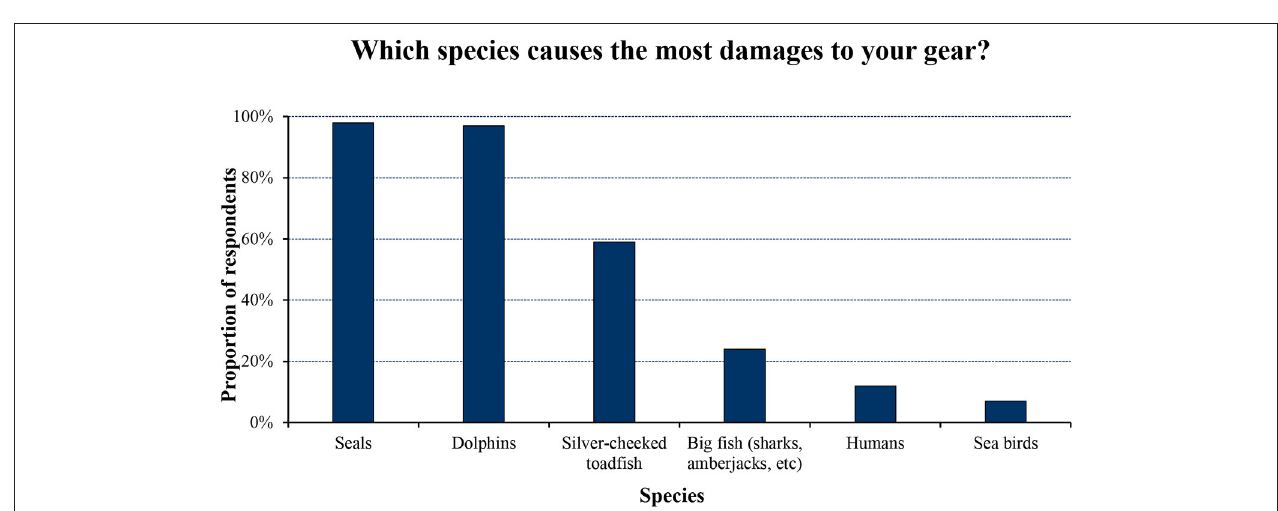
FIGURE 4 | Species reported to be causing damage to fishing gear of fishermen on Crete. Figure represents responses to the question “What [other] species [damage your gear]?” Fishermen described several species they were interacting with, therefore, the percentages did not add up to 100. It was interesting to note that even desirable fish species like amberjacks caused damage to gear and that on a few occasions even humans were reported to cause